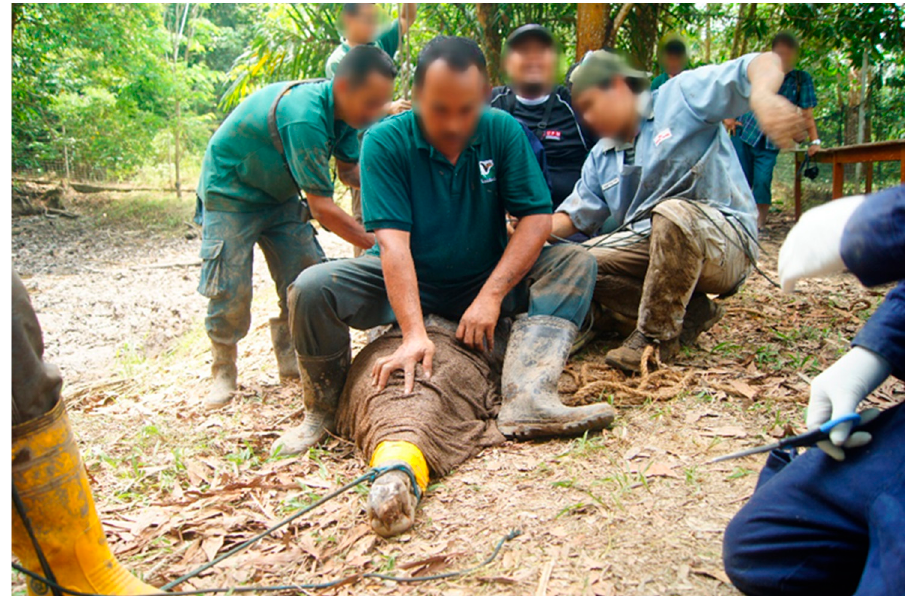
Figure 1. Showing false gharial restraint, where a few people sit on top of the false gharial to pin the animal down for